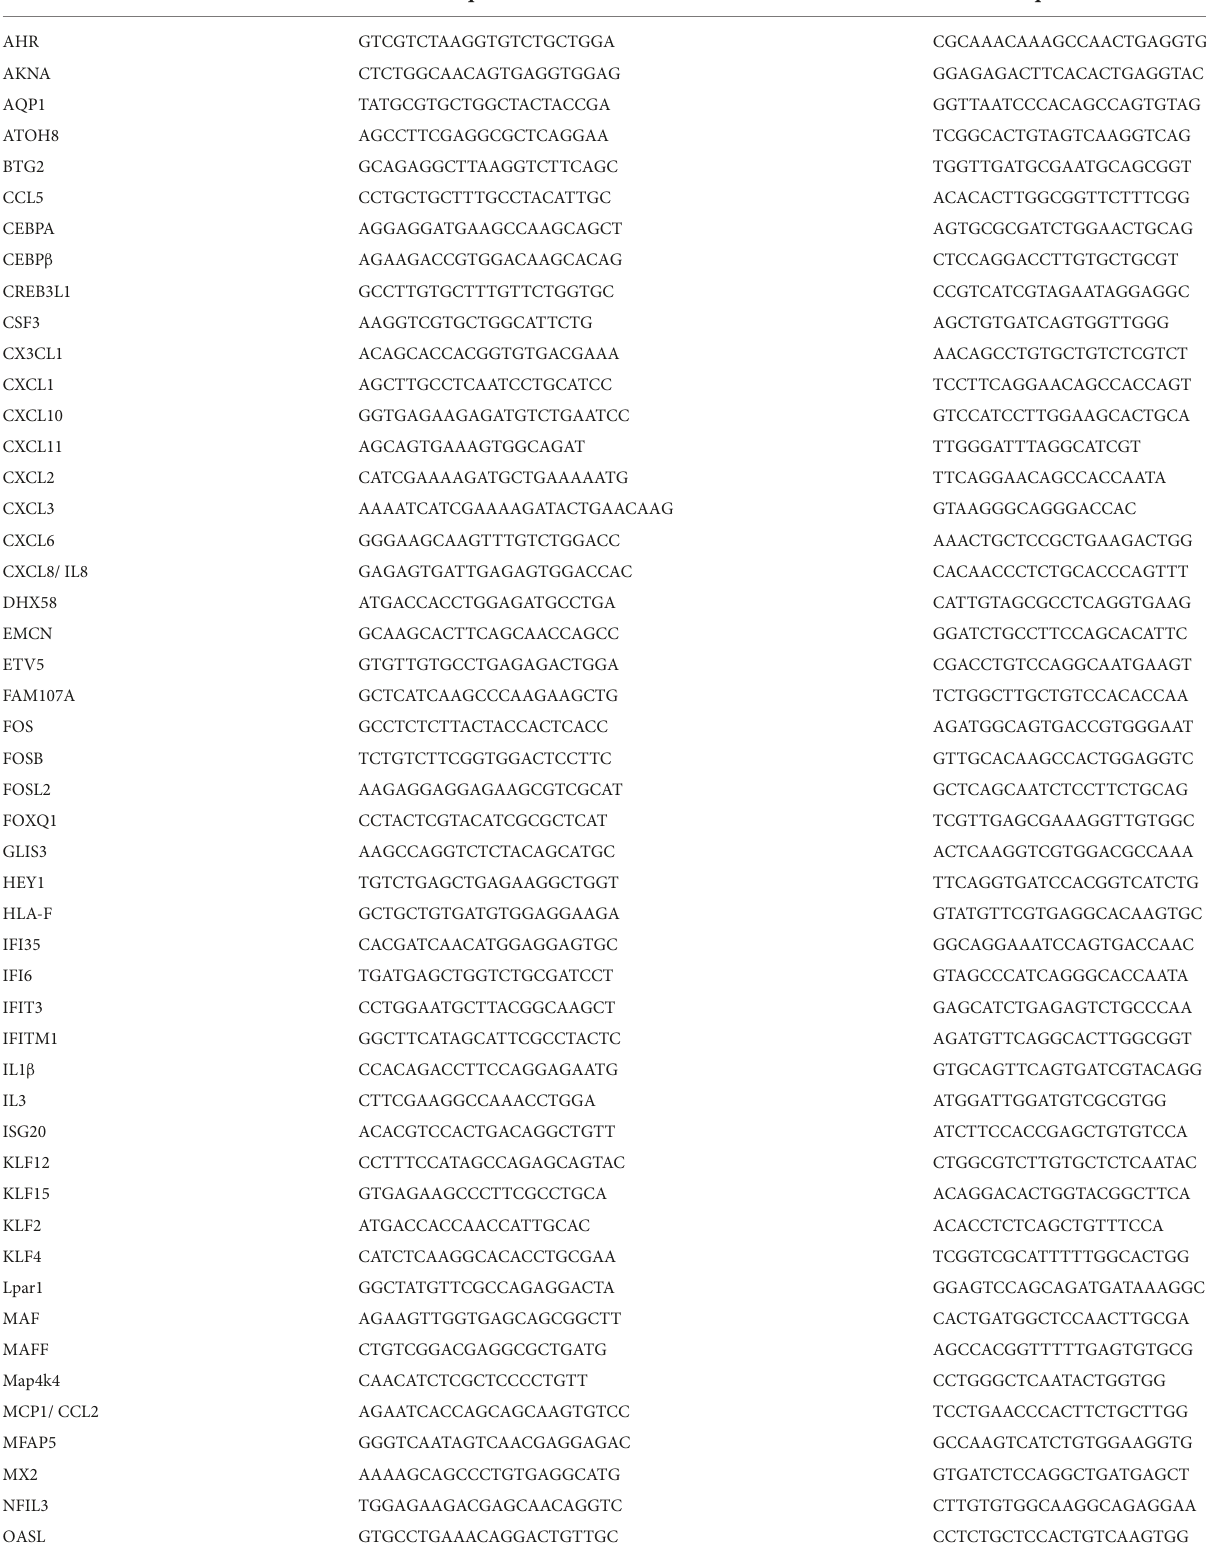
TABLE 2 Human qPCR primer